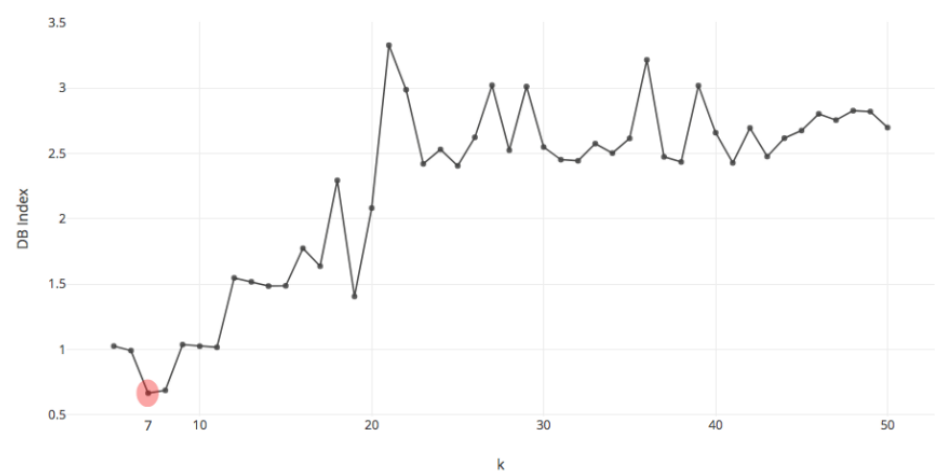
Figure 5. DB index at different k values. The horizontal axis represents the k value, and the vertical axis represents the DB index. When k = 7, the DB Index value is minimum .